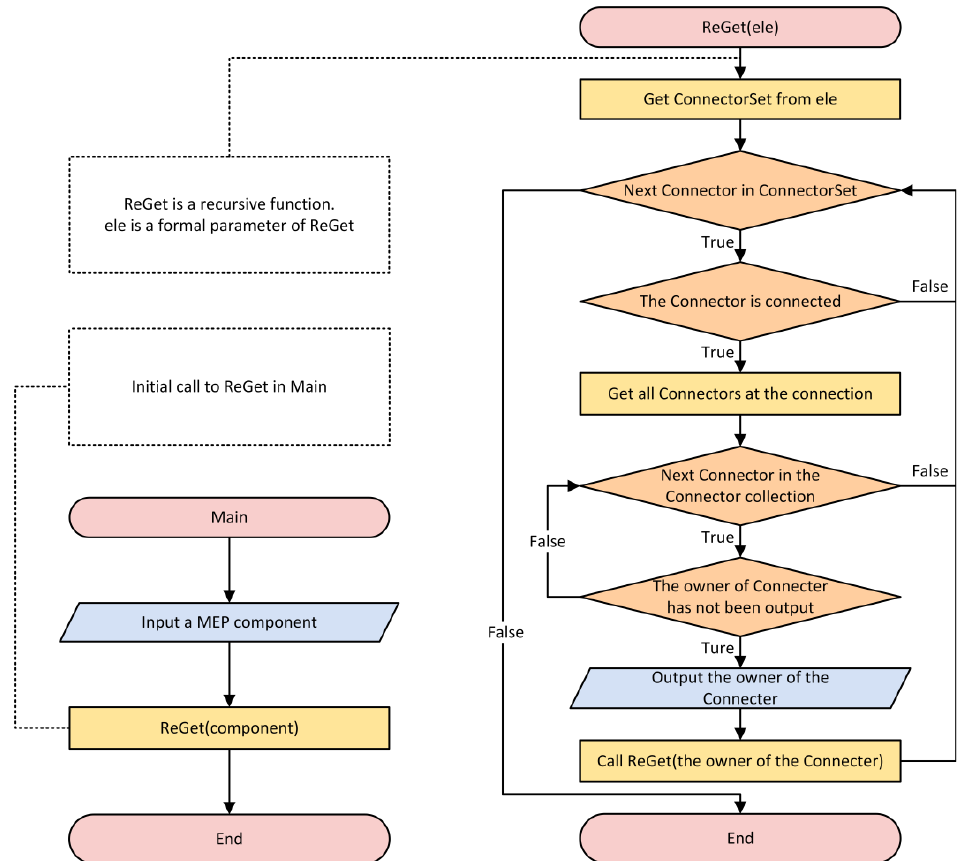
Figure 10. Algorithm for system integrity checking.